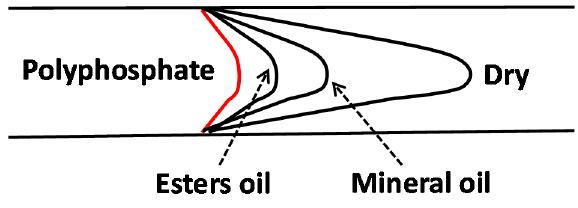
Figure 8. Schematic of shear strain profile under different lubrication conditions including polyphosphate lubricant effect on the ferrite deformation of IF steel